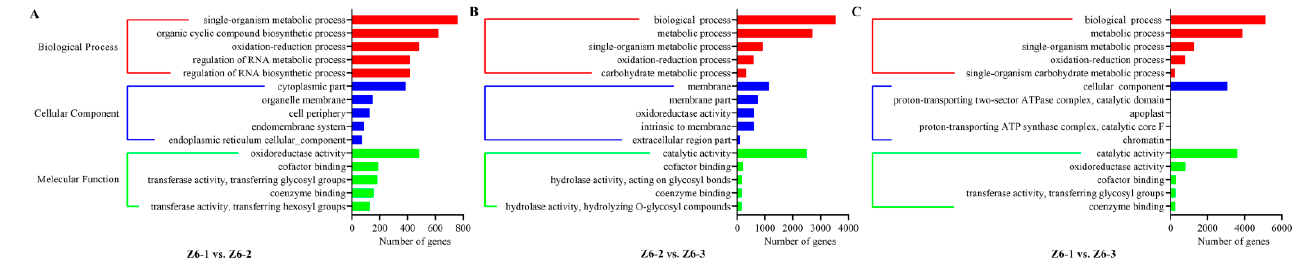
Figure 3. GO enrichment analysis of DEGs on pairwise comparisons. ( A ) Comparison of Z6-1 vs. Z6-2. ( B ) Comparison of Z6-2 vs. Z6-3. ( C ) Comparison of Z6-1 vs. Z6-3.